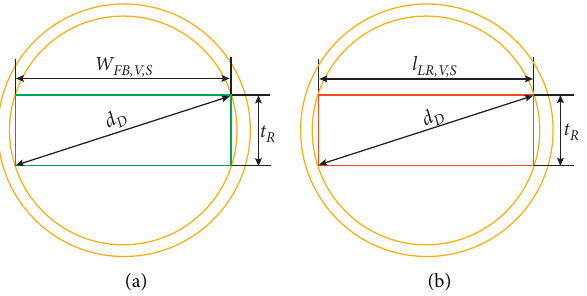
Figure 8: Top view of a finally segmented piece from the rectangular prism-type object placed into the container: (a) a segmented piece from front/back walls; (b) a segmented piece from left/right walls.